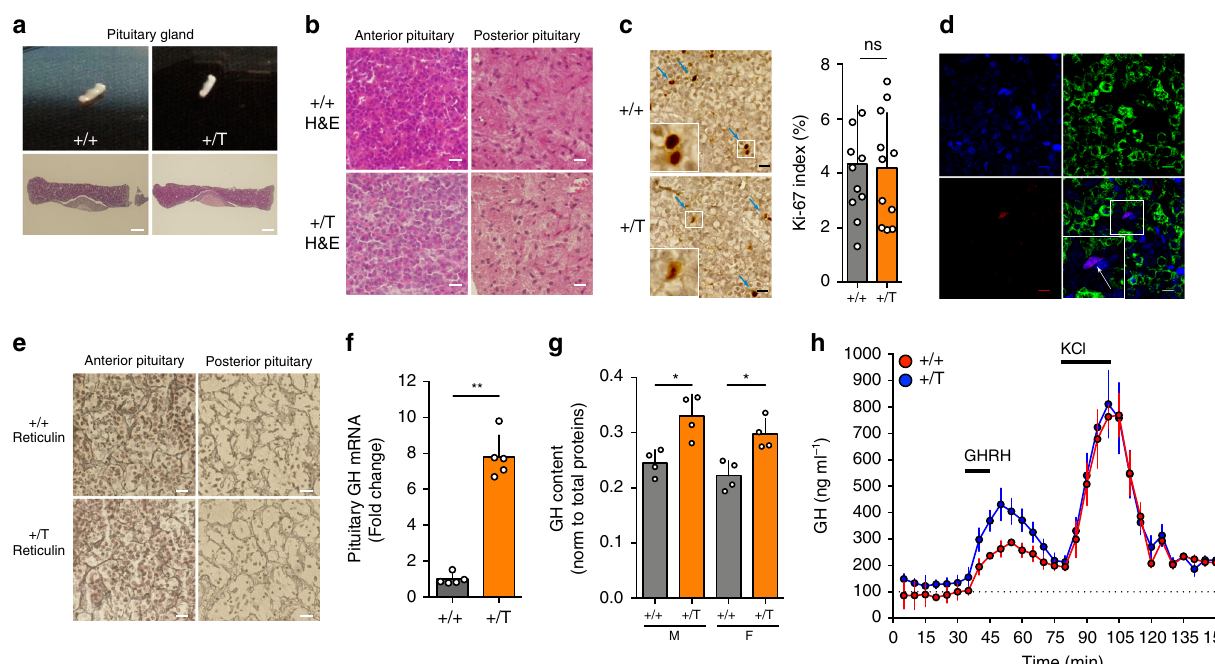
Fig. 3 Gpr101 overexpression potentiates GH release but does not lead to hyperplasia/tumorigenesis. a Upper panel: Macroscopic analysis of the pituitary gland from 27-week-old WT ( + / + ) and Ghrhr Gpr101 ( + /T) mice. Lower panel: microscopic visualization of pituitary sections after H&E staining. Scale bar: 150 µ m. b High magni fi cation of anterior and posterior pituitaries stained with H&E. Scale bar: 15 µ m. c Left panel: Immunohistochemical staining of the anterior pituitary sections with the cell proliferation marker Ki-67 (scale bar: 15 µ m). Blue arrows indicate Ki-67-positive nuclei staining. Right panel: quanti fi cation of the Ki-67 labeling index in pituitary sections of 27-week-old WT ( + / + ) and Ghrhr Gpr101 ( + /T) mice. The Ki-67 labeling index represents the percentage of positive nuclei stained by anti-Ki-67 antibody. n = 11 independent areas from staining section of WT ( + / + ) and Ghrhr Gpr101 ( + /T) ( n = 4 mice per group, p = 0.9487). d Immuno fl uorescent staining of GH (green) and Ki-67 (Red). Scale bar: 10 µ m. e Reticulin staining of the anterior